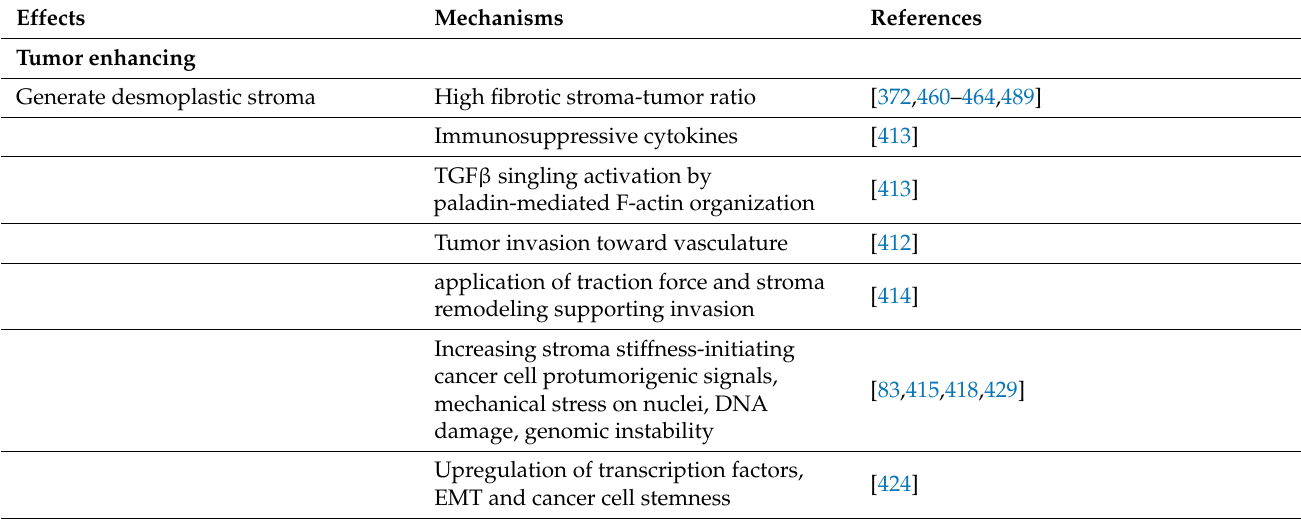
Table 3. CAFs regulate cancer cell